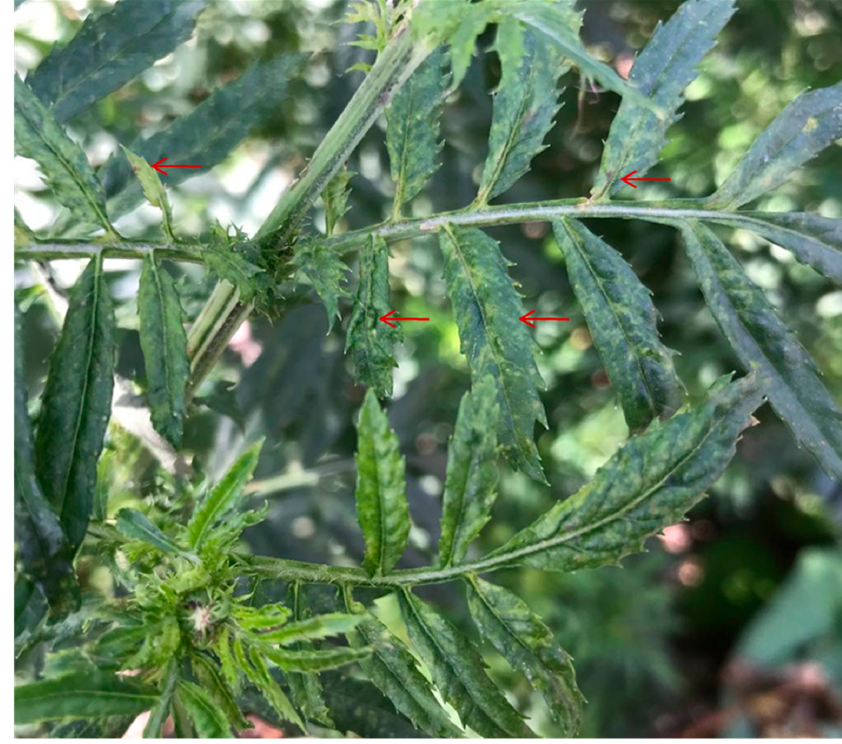
Figure 1. Mosaic, leaf curl, necrosis and crinkle symptoms observed in marigold.